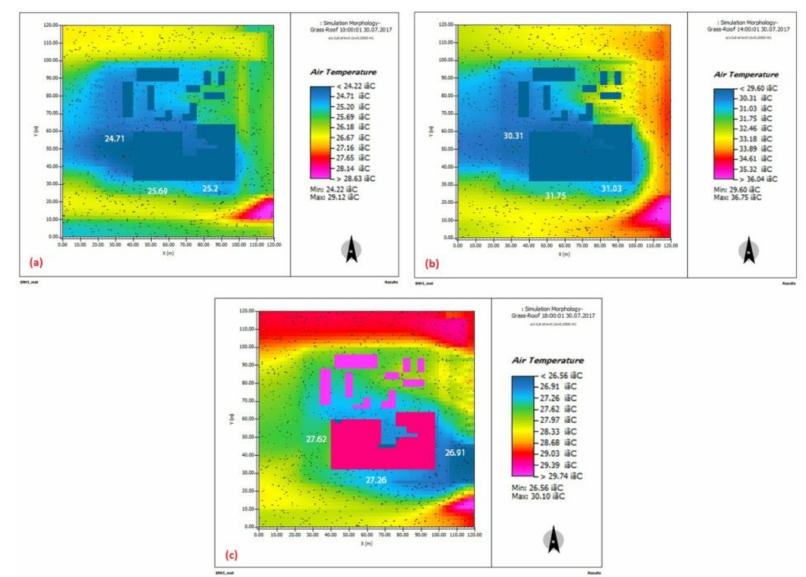
Figure 10. ENVI-met simulation outputs for T air at ( a ) 10:00; ( b ) 14:00; and ( c ) 18:00.